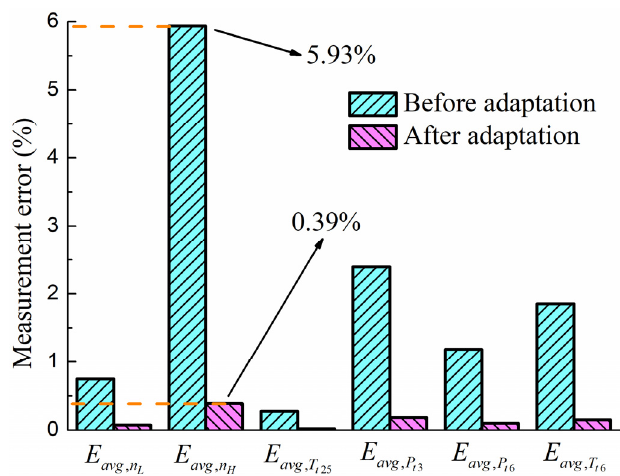
Figure 13. Average error comparison.